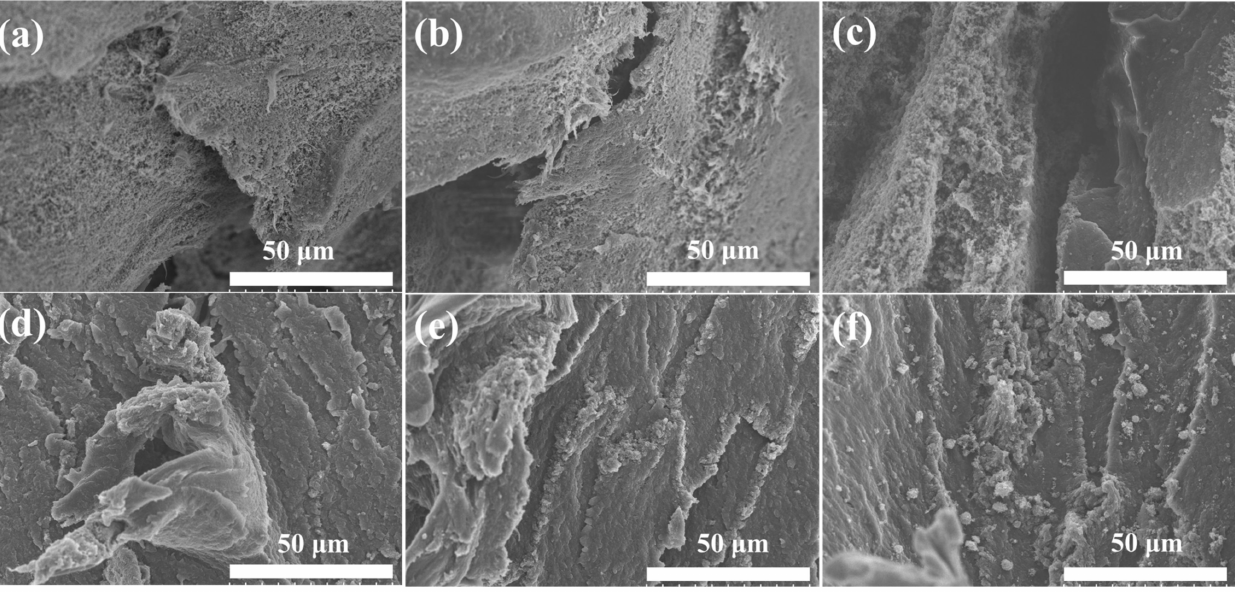
Figure 7. SEM images of the tensile fractured surfaces of UHMWPE/l-CCB composites: ( a ) UHMWPE/l-CCB 5 ; ( b ) UHMWPE/l-CCB 10 ; and ( c ) UHMWPE/l-CCB 15 , and UHMWPE/h-CCB composites: ( d ) UHMWPE/h-CCB 5 ; ( e ) UHMWPE/h-CCB 10 ; and ( f ) UHMWPE/h-CCB 15